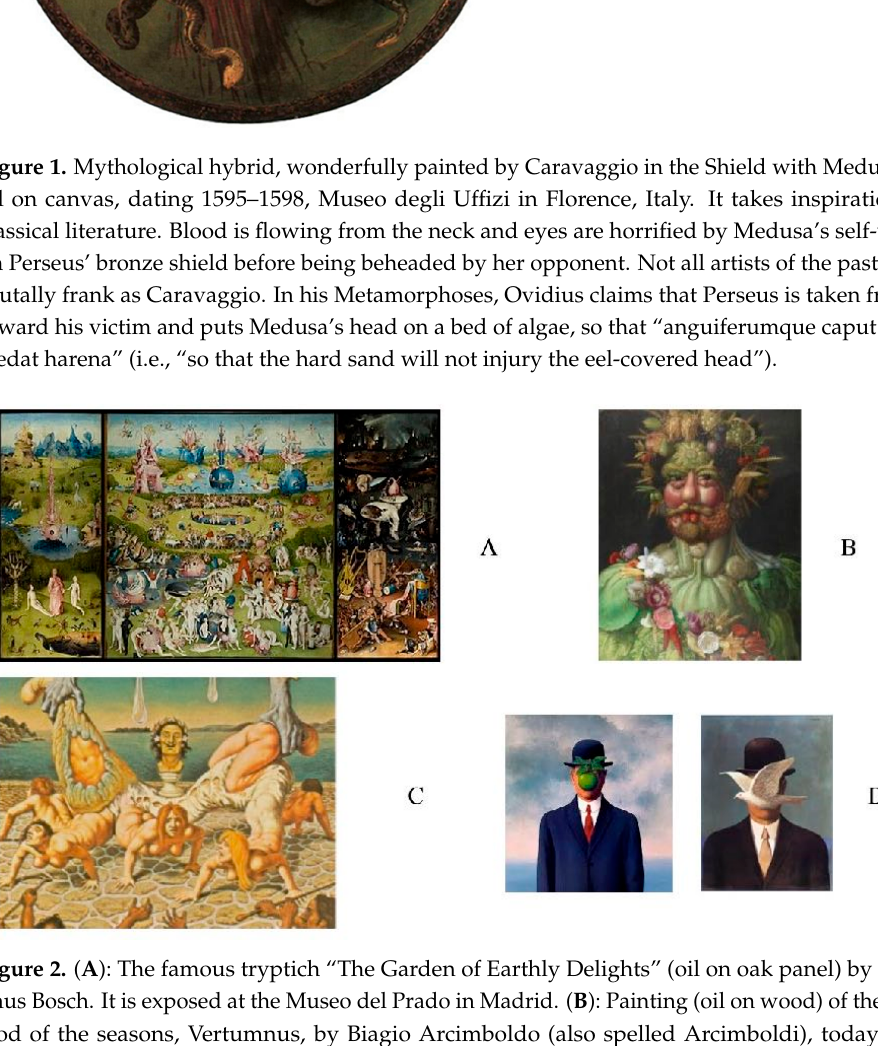
Figure 2. ( A ): The famous tryptich “The Garden of Earthly Delights” (oil on oak panel) by Hyeron- imus Bosch. It is exposed at the Museo del Prado in Madrid. ( B ): Painting (oil on wood) of the Roman God of the seasons, Vertumnus, by Biagio Arcimboldo (also spelled Arcimboldi), today kept at Gripsholm Castle by the Malarian lake, Sweden. ( C ): “The Apotheosis of Dal í ”, by Johfra Bosschart, 1971, appearing on a book by he himself “Highest Lights and Deepest Shadows”. Information about him is not abundant. He is known as an eccentric and extravagant, but fascinating, artist whose work offers a very hard perusal. ( D ): The visionary art of Ren è Magritte is evident in two paintings, named, respectively, “Men’s son”, left, and “Man with bowler hat”, 1964, actually kept in private